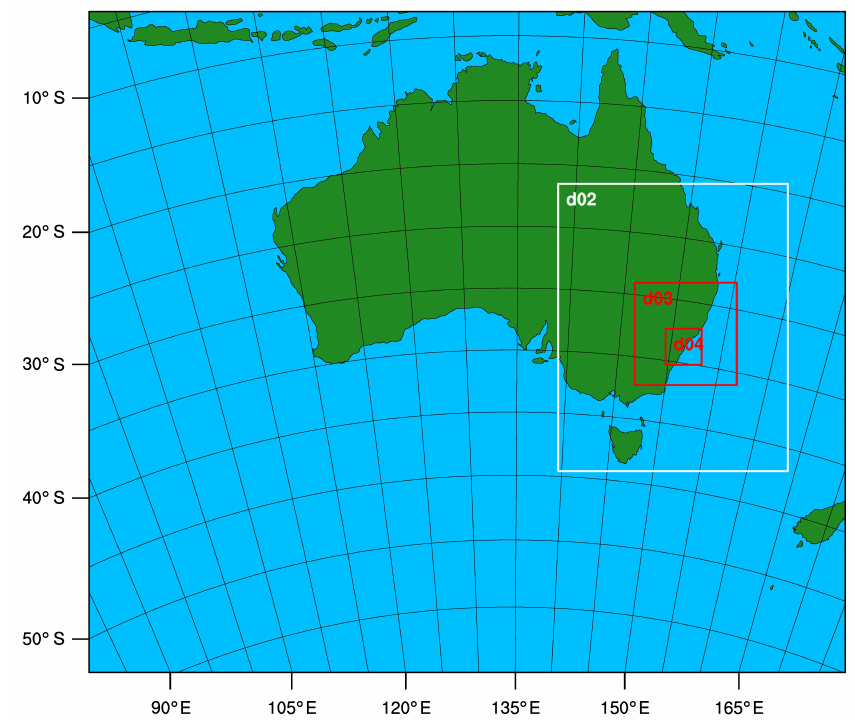
Figure 2. 4-nested domain set-up for WRF-Chem runs used in this study. Domain horizontal resolutions are 81 km (outermost), 27 km (d02, white box), 9 km (d03, red box) and 3 km (d04, red box).